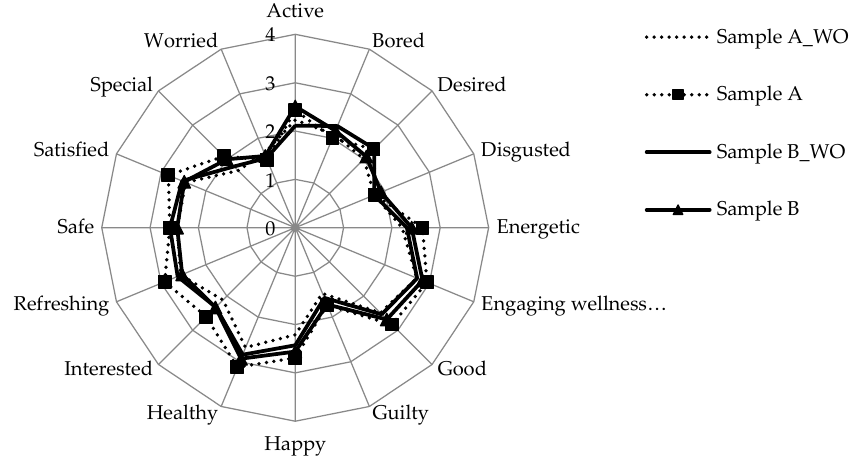
Figure 3. Mean emotion scores elicited by salad size, without (WO) and with product name. Refer to Table 3 for sample (A and B) image and description.